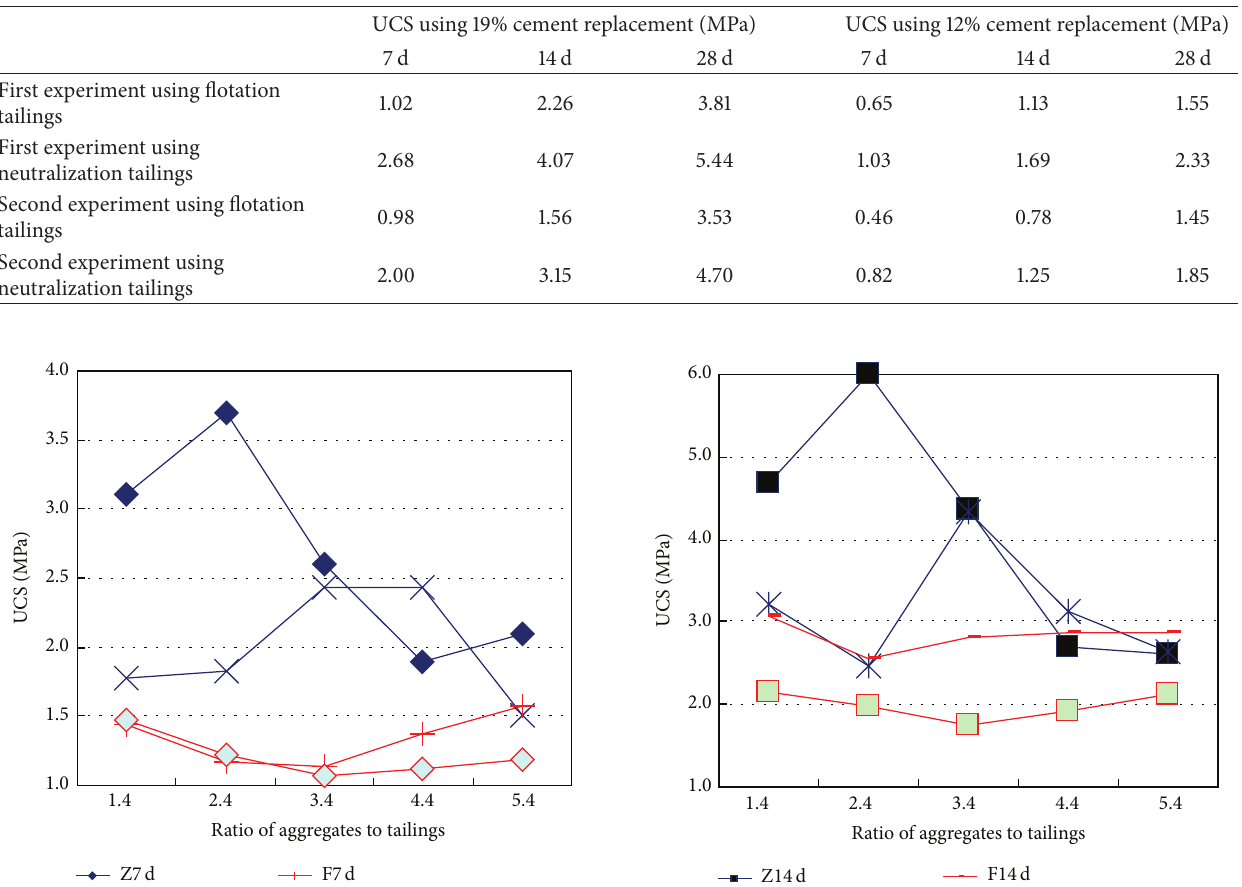
Table 4: UCS backfill strength comparison of two types of tailings.